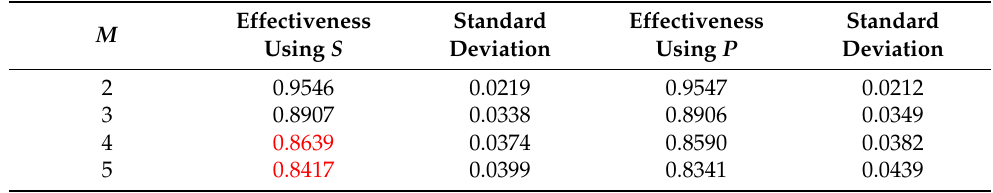
Table 7. Comparison of effectiveness using the reflexive relation S and using the asymmetric relation P in the context of the number of